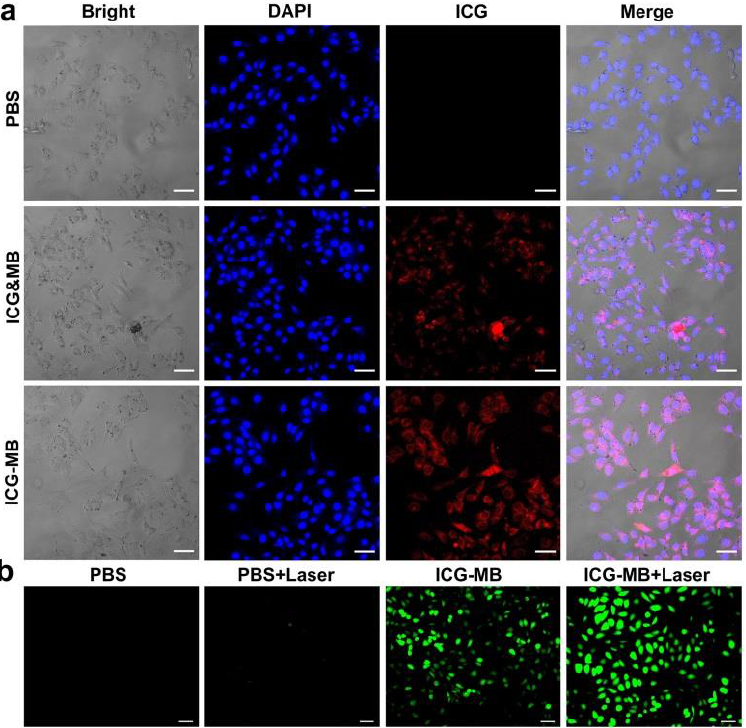
Figure 4. ( a ) Cellular uptake of ICG-MB nanoparticles. Scale bar: 20 μm. ( b ) Intracellular ROS generation treated with ICG-MB nanoparticles with 670 nm laser irradiation. Scale bar: 50